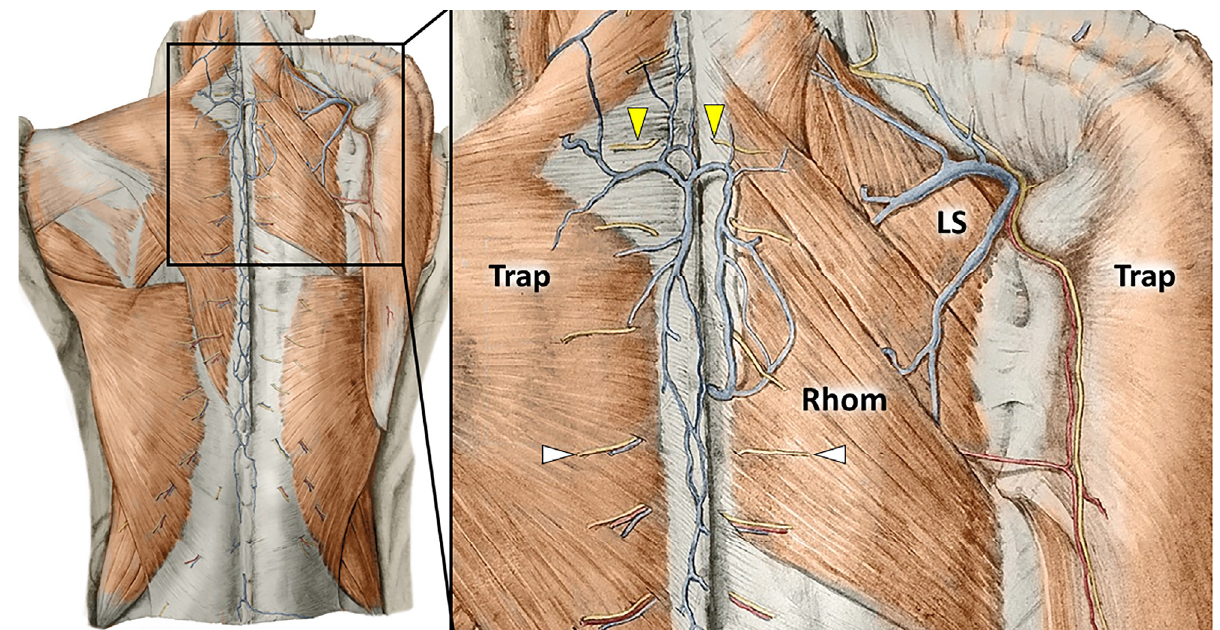
Figure 3. Anatomical drawings show the CBsDR of spinal nerves piercing the muscular (white ar- rowheads) and aponeurotic (yellow arrowheads) components of the trapezius (Trap) and rhomboid (Rhom) muscles to reach the subcutaneous tissue at the cervical/thoracic spine. LS: levator scapulae muscle.